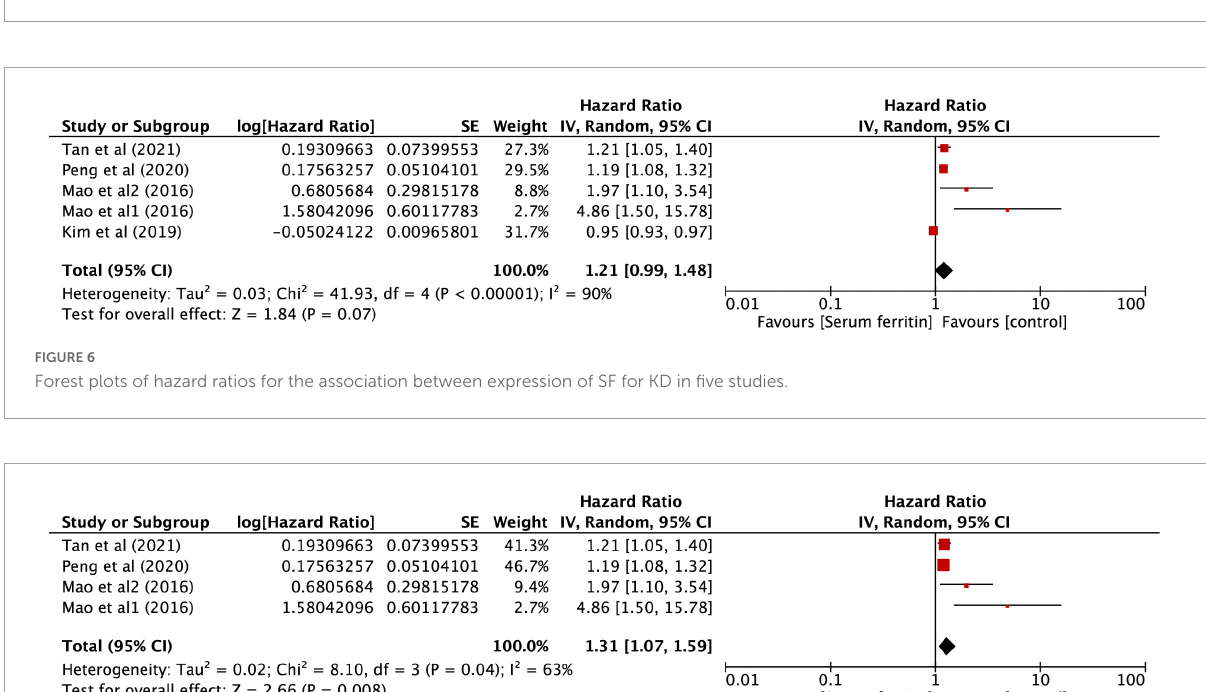
FIGURE5 Estimation of diagnostic accuracy of SF vs. control (fever, healthy, and s-JIA) in KD. (A) Summary receiver operator characteristic (SROC) curve; (B) bivariate boxplot; (C) Galbraith plot; (D) Cook’s distance plot; (E) Fagan’s nomogram; (F) Deek’s funnel plot.